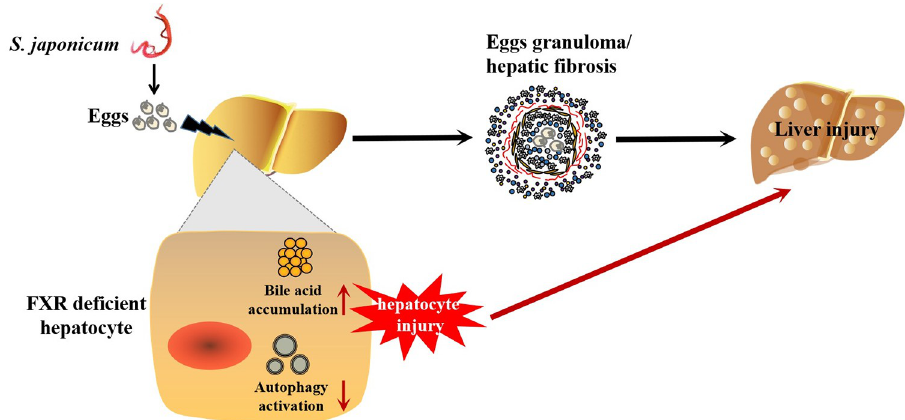
Fig 7. A schematic model shows that FXR deficient in hepatocytes increases bile acids toxicity and inhibits hepatocellular autophagy, which may therefore accelerate the progression of schistosomiasis by promoting hepatocytes